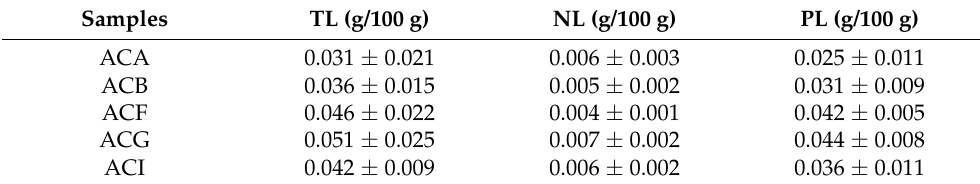
Table 1. The yield of extraction for the total lipids (TL), neutral lipids (NL) and polar lipids (PL) of the apple ciders ACA, ACB, ACG, ACG, and ACI, expressed as g/100 g of sample (mean ± SD, n =